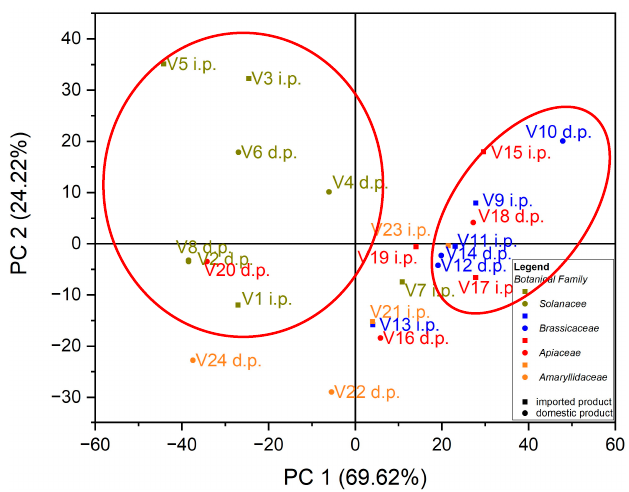
Figure 3. Chart of scores for PC2 vs. PC1 for PCA analysis, using as input data the content of trace elements for the analyzed vegetable samples.